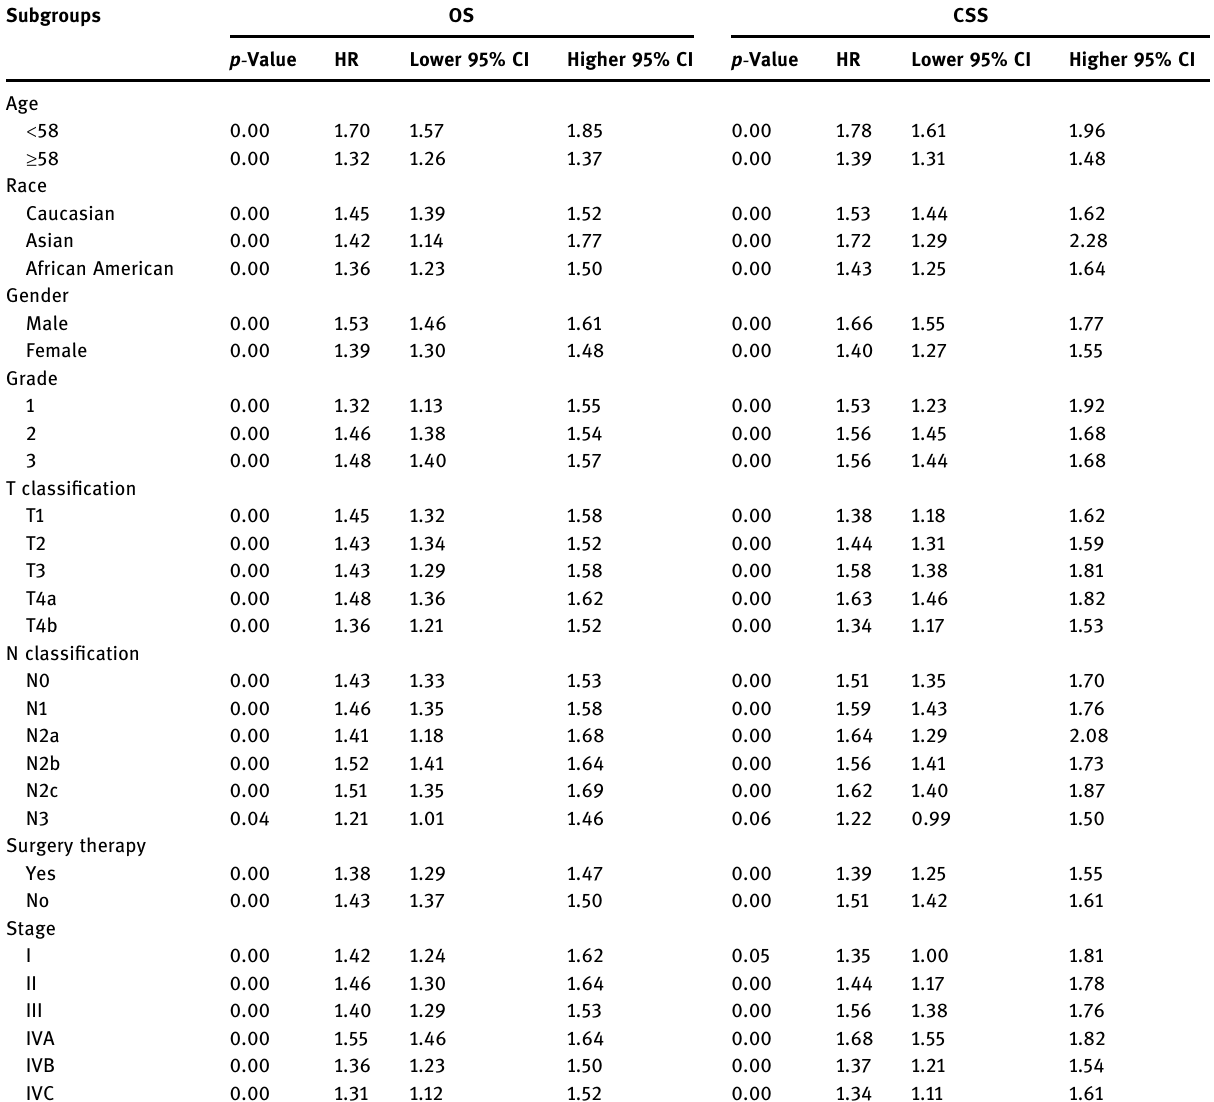
Table 4: E ff ect of marital status on OS and CSS based on di ff erent subgroup variables Subgroups OS